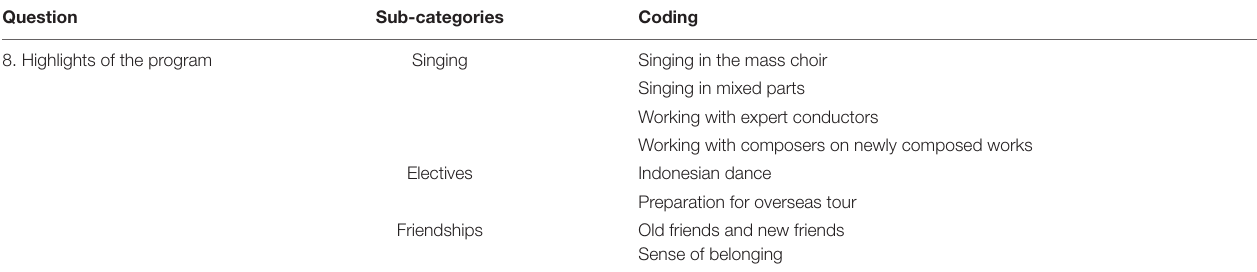
TABLE 3 | Mapping of findings from the initial analysis to the five themes. Theme (Barrett and Smigiel,